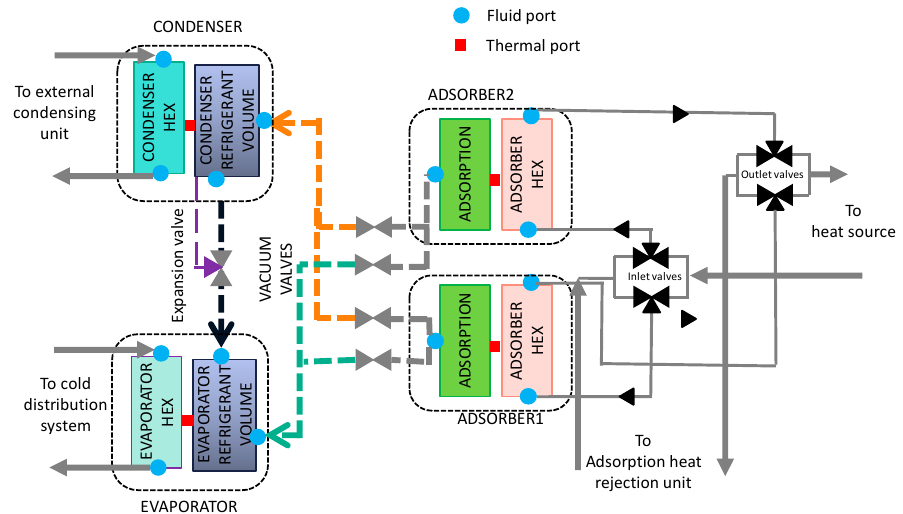
Figure 2. Layout of the model of the adsorption module with the indication of fluid ports and thermal ports as in the model implementation in Dymola.